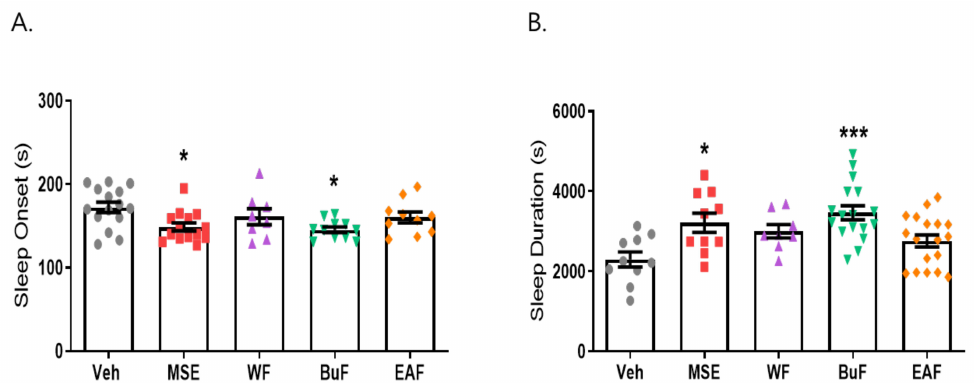
Figure 6. Effects of Maydis stigma extract fractions in pentobarbital-induced sleep animal model. Mice were administered the three fractions (WF, BuF, and EAF; 10 mg/kg) of Maydis stigma extracts (MSE) and MSE (100 mg/kg) for 7 days orally. Sleeping test was performed on day 8. Sleep latency and sleep duration were measured as described in Section 4. ( A ) Sleep latency (s), ( B ) sleep duration (s). * p < 0.05, *** p < 0.001; Veh vs. MSE, WF, BuF, and EAF (N = 8–12).